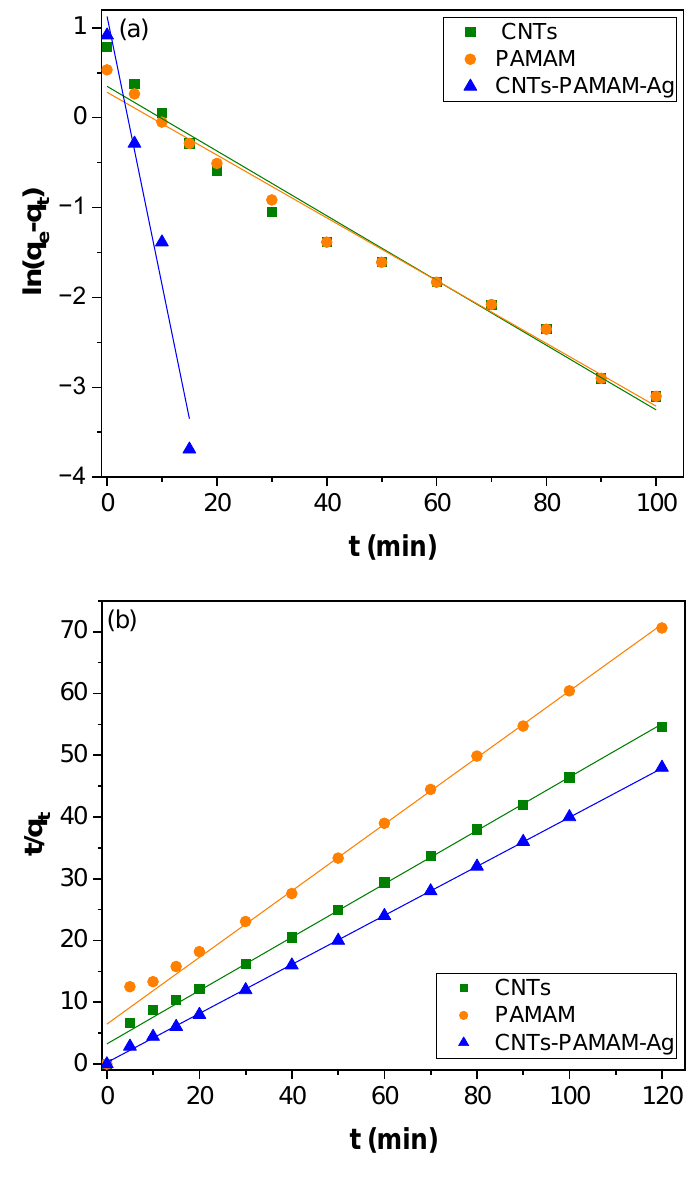
Figure 6. ( a ) Pseudo-first-order and ( b ) pseudo-second-order kinetics for Pb(II) adsorption over oxidized CNTs, PAMAM and